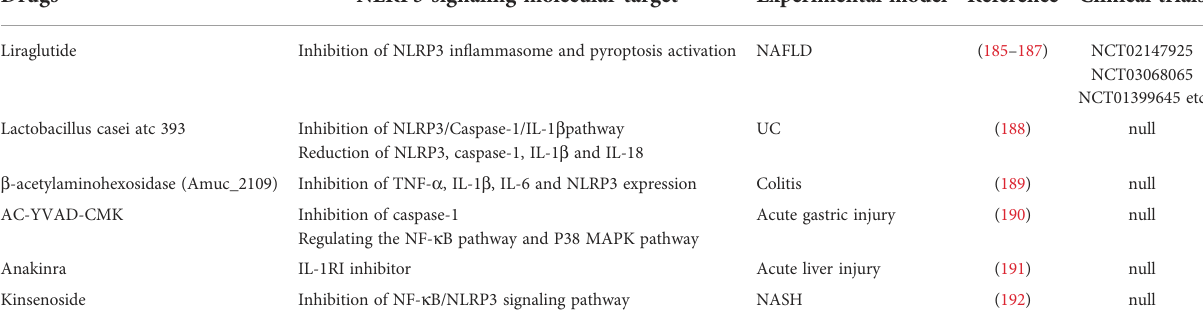
TABLE 3 Biologics able to inhibit NLRP3 in fl ammasome in digestive diseases. Drugs